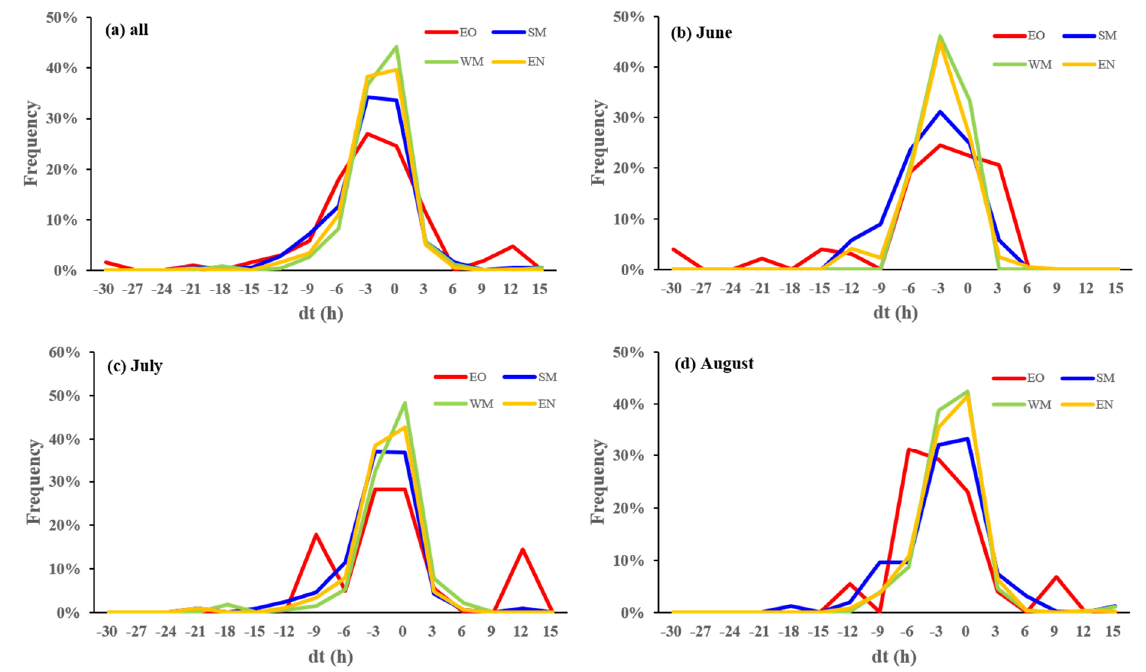
Figure 15. Difference in occurrence time ( ∆ t) between BT min and P max for EOs (red), SMs (blue), WMs (green) and ENs (yellow). Negative ∆ t means BT min occurs earlier than P max . ( a ) Whole summer; ( b ) June; ( c ) July; ( d ) August.